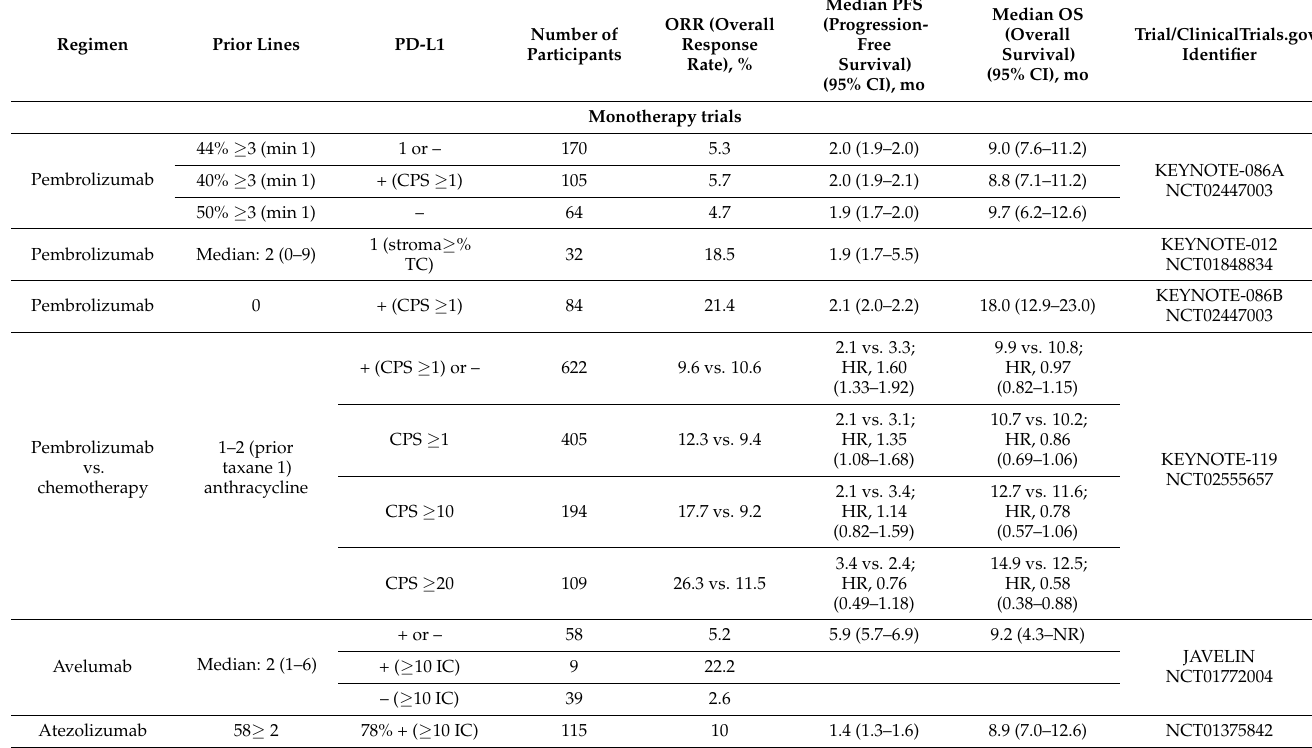
Table 5. Monotherapy and chemotherapy anti-PD-1/L1 trials in metastatic